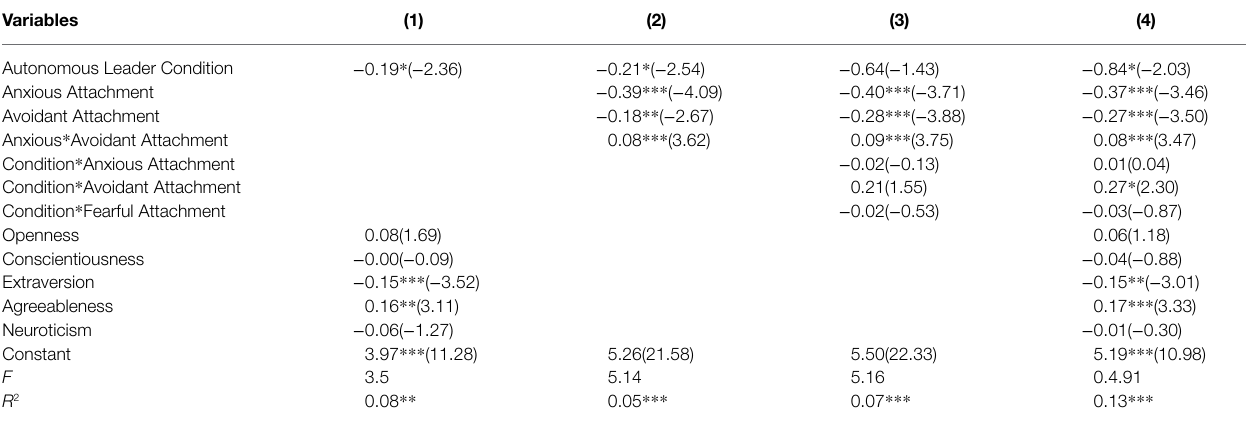
TABLE 3 | Regression estimates (Study 2): perceived leader competence. Variables